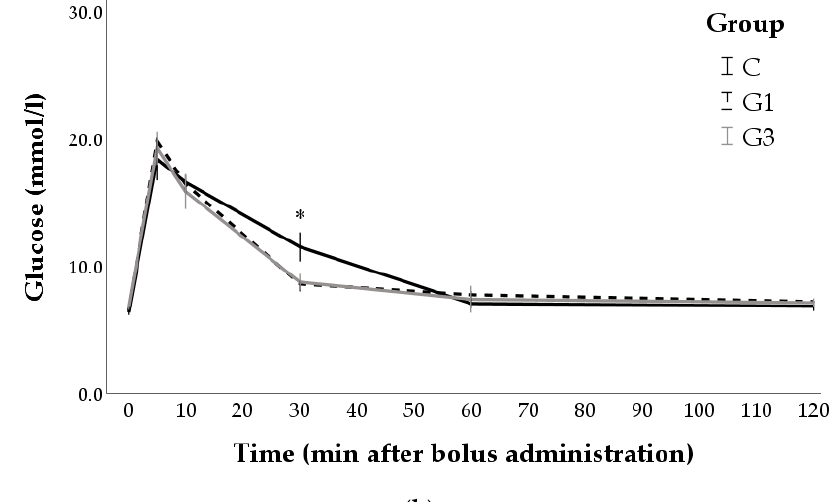
Figure 2. Changes in blood glucose levels after bolus administration in pregnant does ( a ) and 90-day-old rabbits ( b ) of control group (C, n = 7/category) and groups with 1% (G1, n = 7/category) or 3% (G3, n = 7/category) of Goji berry. * p < 0.05: G3 vs C group.